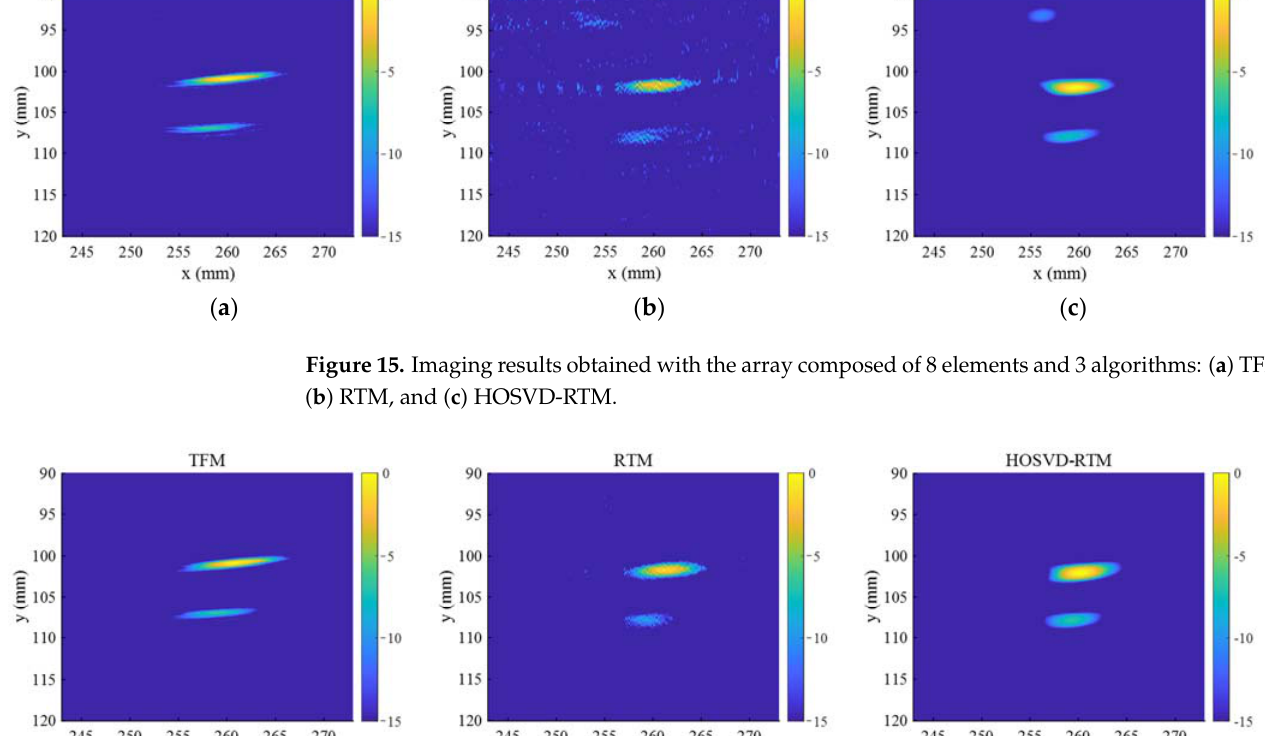
Figure 15. Imaging results obtained with the array composed of 8 elements and 3 algorithms: ( a ) TFM, ( b ) RTM, and ( c ) HOSVD-RTM. Figure 16. Imaging results obtained with the array composed of 16 elements and 3 algorithms: ( a ) TFM, ( b ) RTM, and ( c ) HOSVD-RTM. Table 3. Lateral width of − 6 dB for the defects in different imaging results (mm).